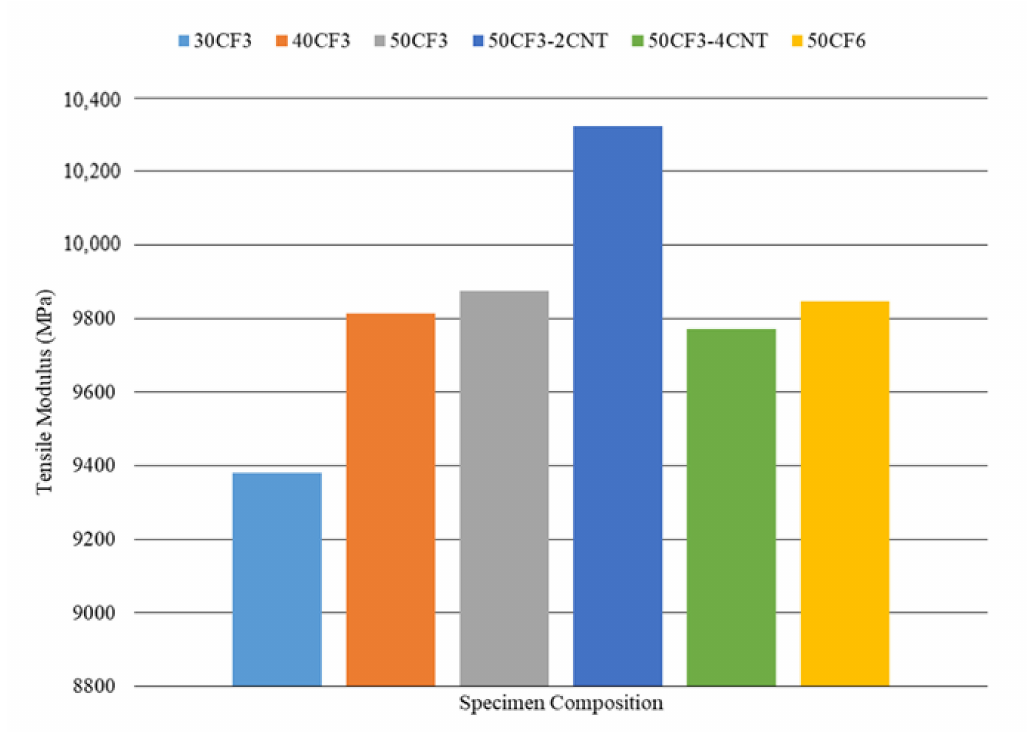
Figure 9. Average tensile modulus of elasticity for di ff erent specimen compositions. Table 3. Average and coe ffi cient of variation of tensile modulus for di ff erent specimen compositions. Composition 30% CF3 40% CF3 50%